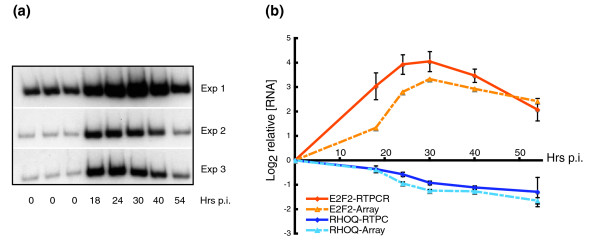
Changes in RNA concentrations in Ad5-infected HFFs determined by RT-PCR. (a) Autoradiograms of products of reverse transcription (RT)-polymerase chain reaction (PCR) amplification of CDC6 RNA isolated from human foreskin fibroblasts (HFFs) infected for the periods indicated. The RNA samples used in experiment 1 were those also used for amplification and hybridization to microarrays, whereas experiments 2 and 3 total RNAs were from two other independent infections of quiescent HFFs. (b) The RT-PCR signals for E2F2 and RHOQ RNAs from the three independent infections were quantified, as described in Materials and methods, zero transformed against the mean of the three zero time point samples included in each experiment, and converted to log2 values for comparison to the changes in concentration of these RNAs determined by hybridization to microarrays. Ad5, adenovirus type 5.